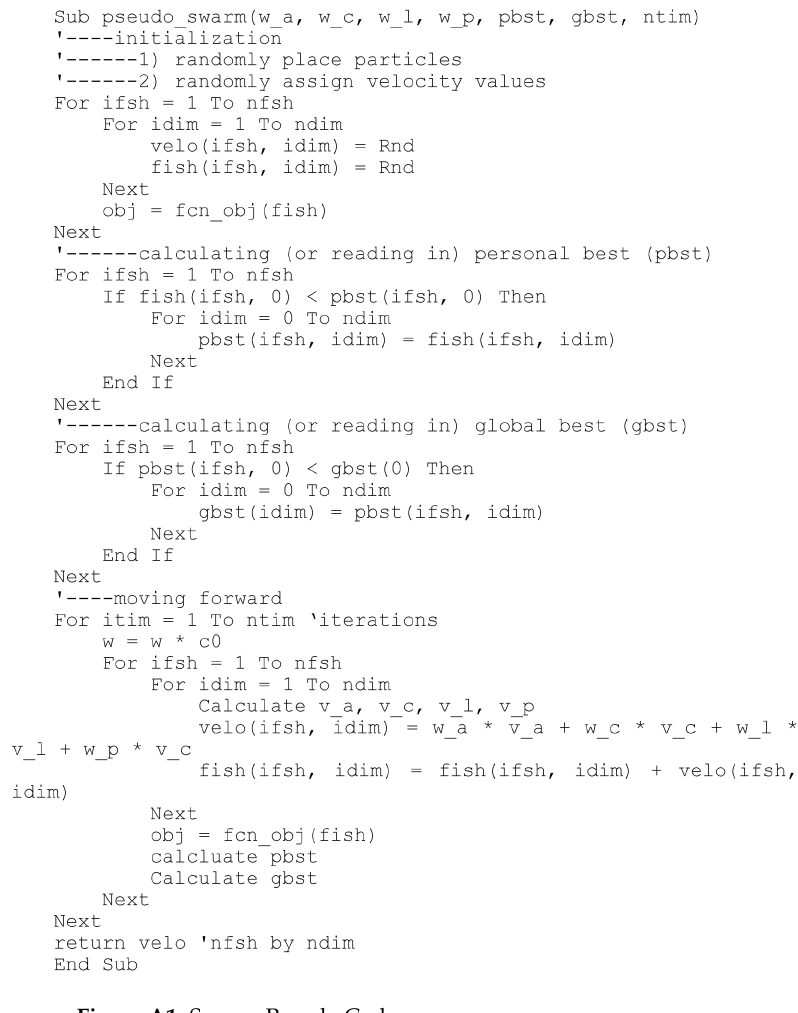
Figure A1. Swarm Pseudo Code.